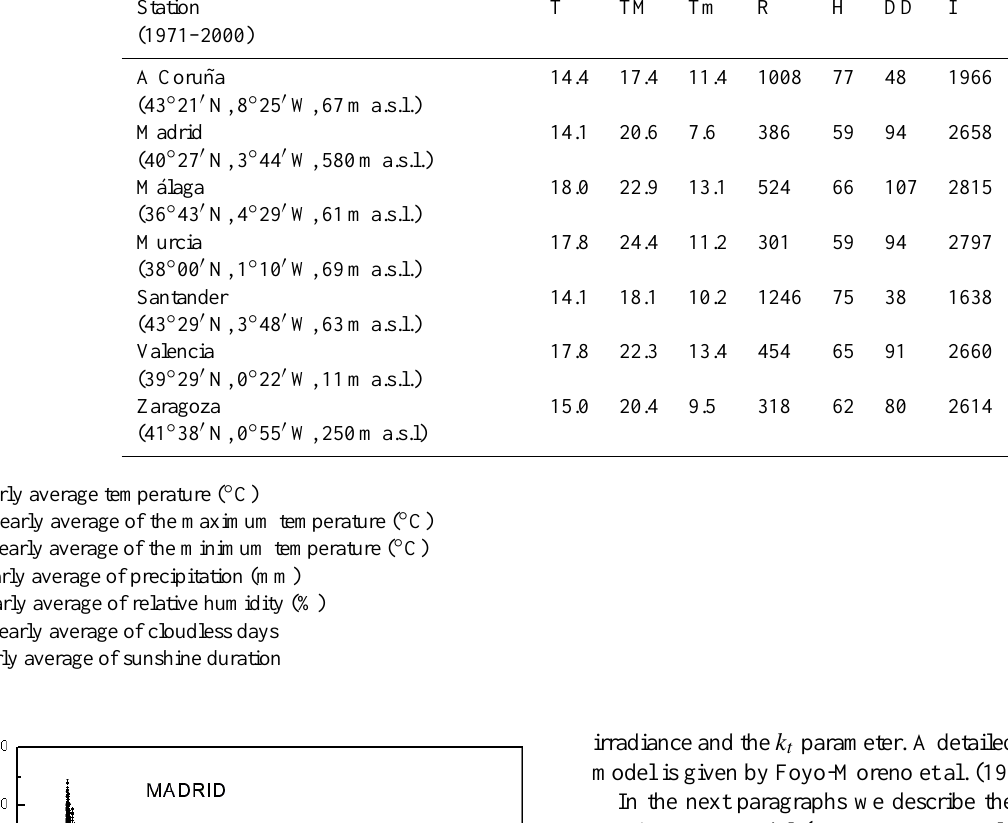
Table 1. Climatic data for the analyzed stations for the period 1971–2000. Station